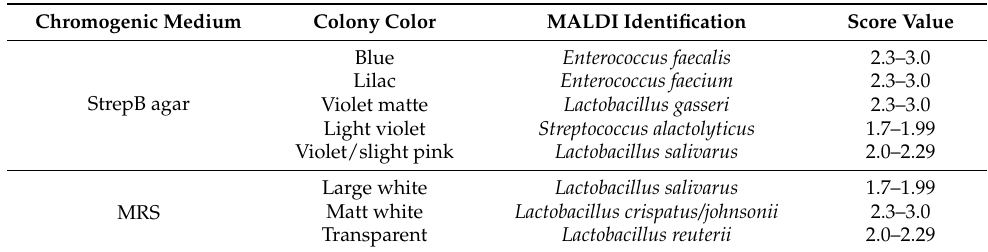
Table 5. MALDI-TOF-MS identification of bacteria species found on StrepB select agar and MRS (DeMan, Rogosa, and Sharpe) agar. Range of score values: 2.3–3.0: Highly probable species identifi- cation; 2.0–2.29: Secure genus identification and probable species identification; 1.7–1.99: Probable genus identification; 0.0–1.69: Non-reliable